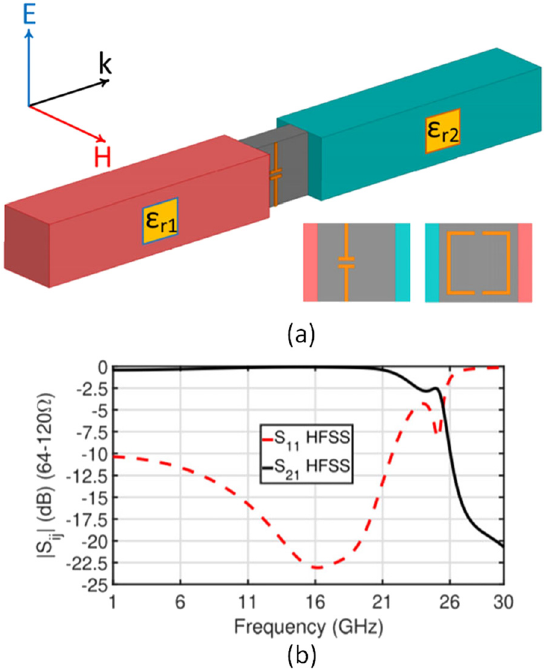
Figure 18: (Reprinted with permission from Ref. [26], © The Optical Society).(a)Scatteringofawaveimpingingontheinterfaceunderan arbitrary angle ( θ a ) , with conventional Fresnel transmission and re fl ection for the case of the bare interface (left) and with re fl ectionless (Brewster) transmission when a properly designed metasurfaceisplacedattheinterface(right).(b)Fullwavesimulated electric fi eld amplitude distribution and (c) angular response of the re fl ectance and transmittance for polarization-independent xz -plane Brewster metasurfaces with the general parameters ( ϵ , ϵ ) = ( 1 , 3 ) for generalized Brewster angle at θ ° r , a a = 30 r , b